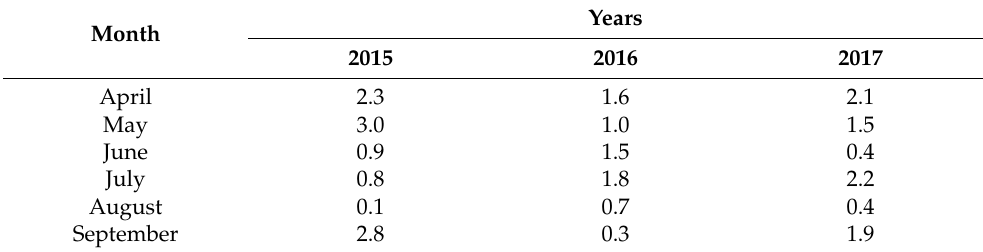
Table 2. Hydrothermal coefficient of Sielianinov * in vegetation periods (2015–2017) according to the meteorological station in